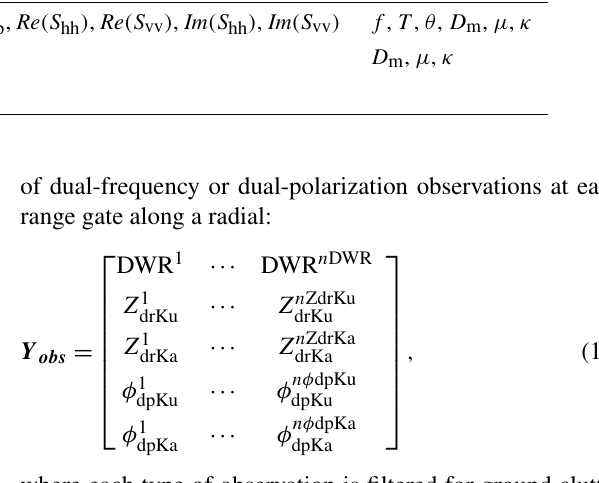
Table 4. Variables stored within the lookup tables. Group Variables Dimensions Radar variables Physical variables Simulated PIP measurements D mP , a box , a